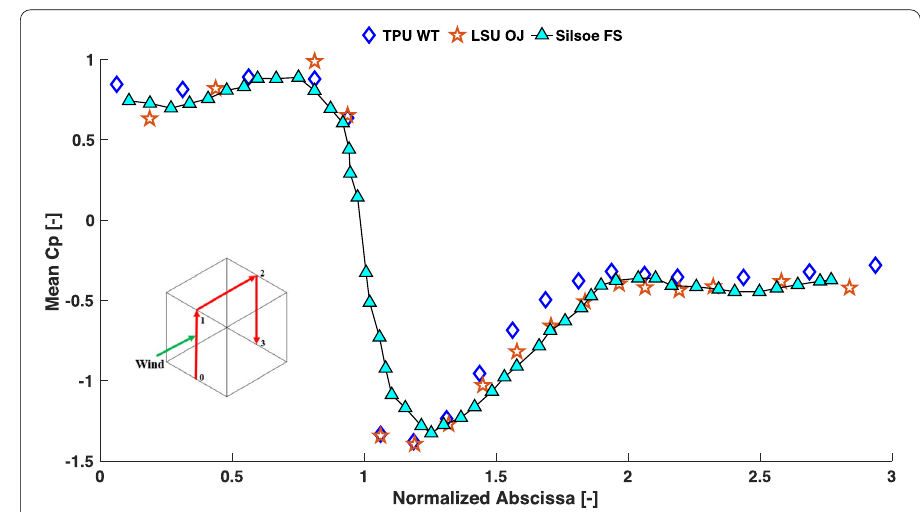
Fig. 12 Comparison of mean pressure coefficients along the vertical ring of the